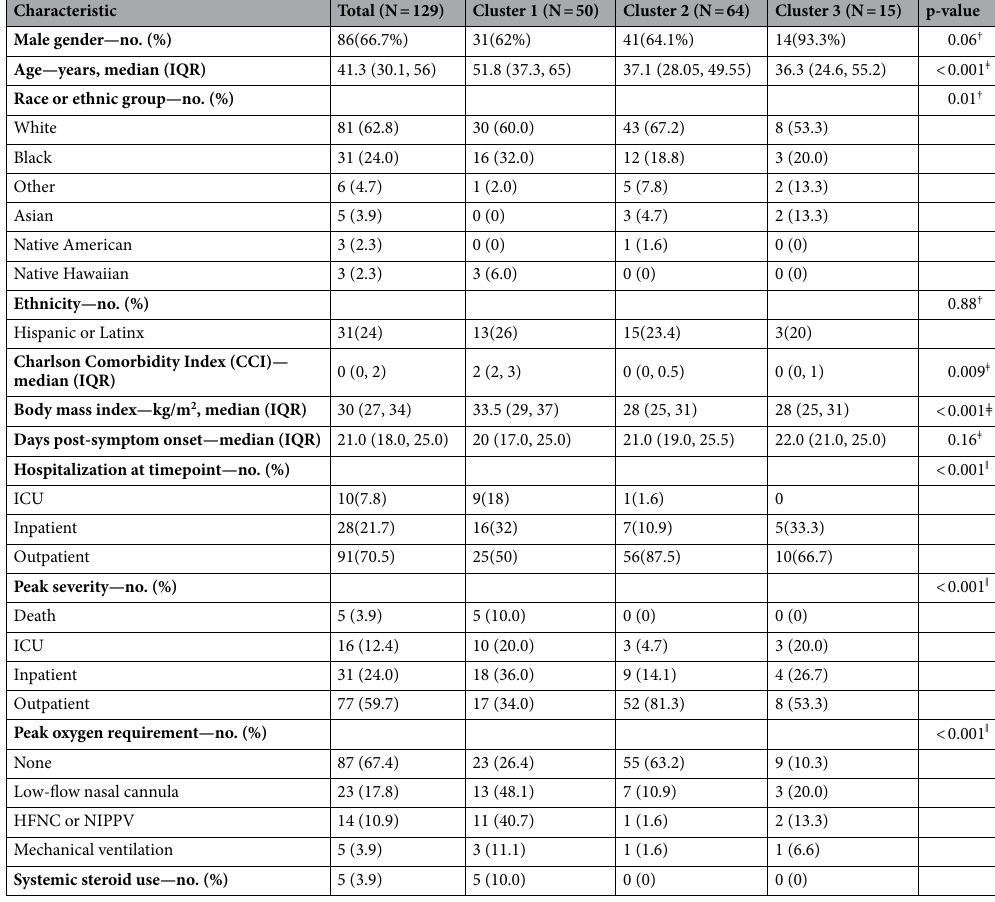
Table 1. Baseline demographics across TDA clusters. IQR: interquartile range; HFNC: high flow nasal cannula; NIPPV: non-invasive positive pressure ventilation. † Chi-square test. ǂ Mann Whitney U test. ǁ Fischer’s Exact